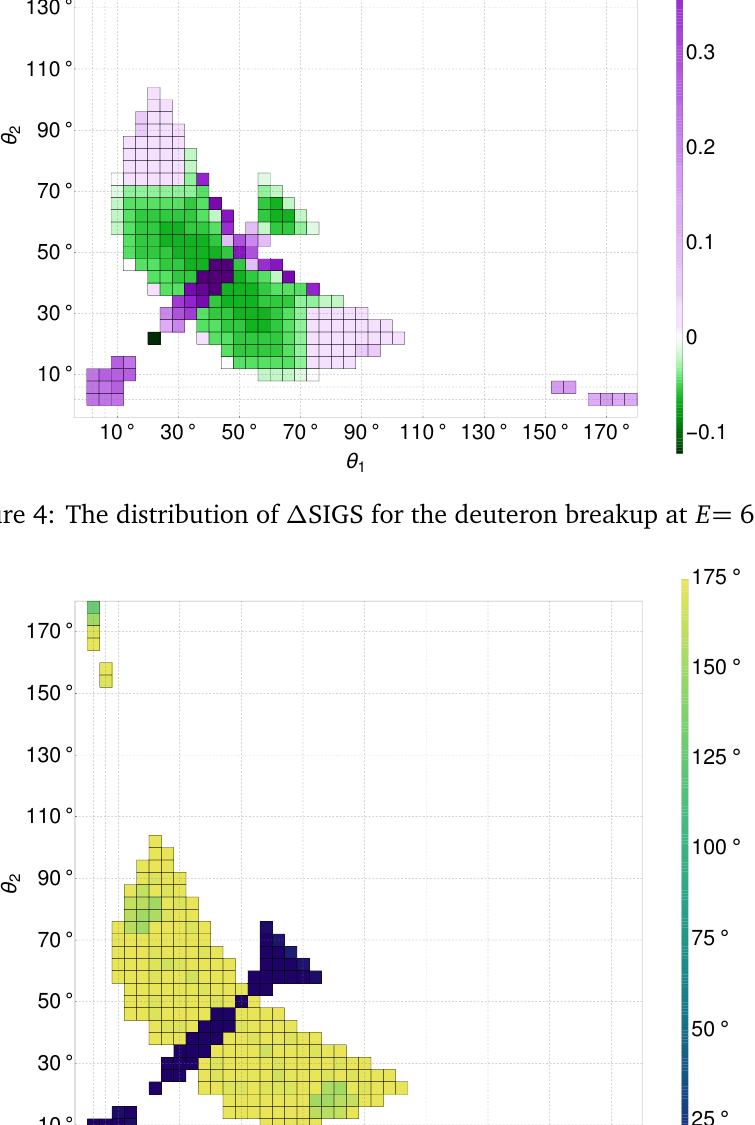
for configurations cor- 12